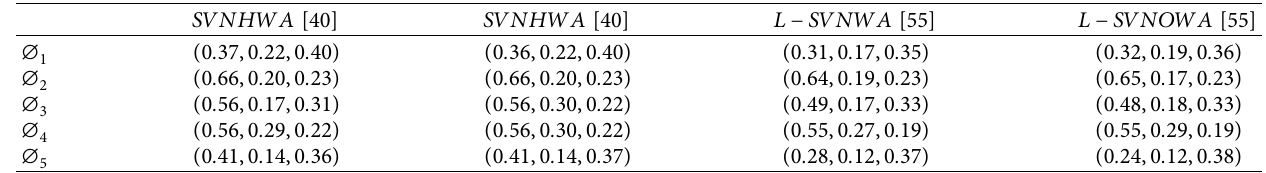
Table 8: Existing aggregated SVN information.